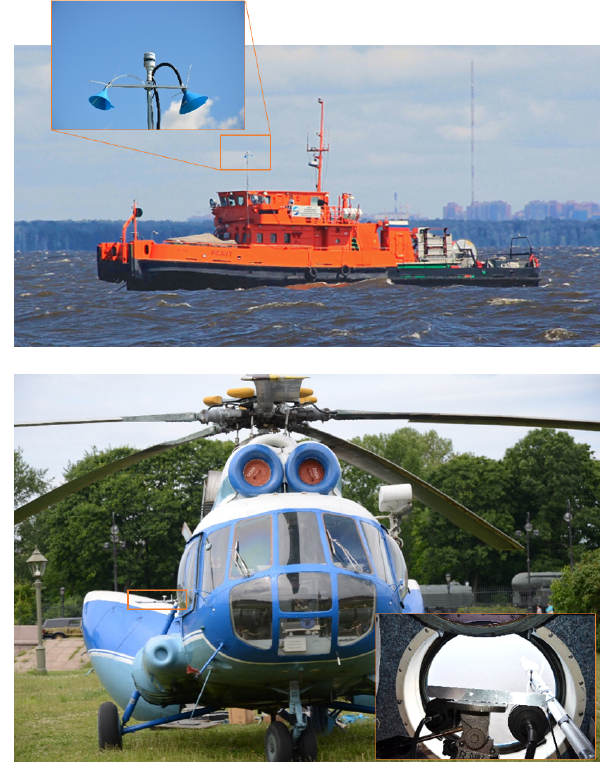
Figure 3. Top: work vessel Redut with sample inlets (photo of Redut taken by M. Pingoud); bottom: Mi-8 helicopter with sample